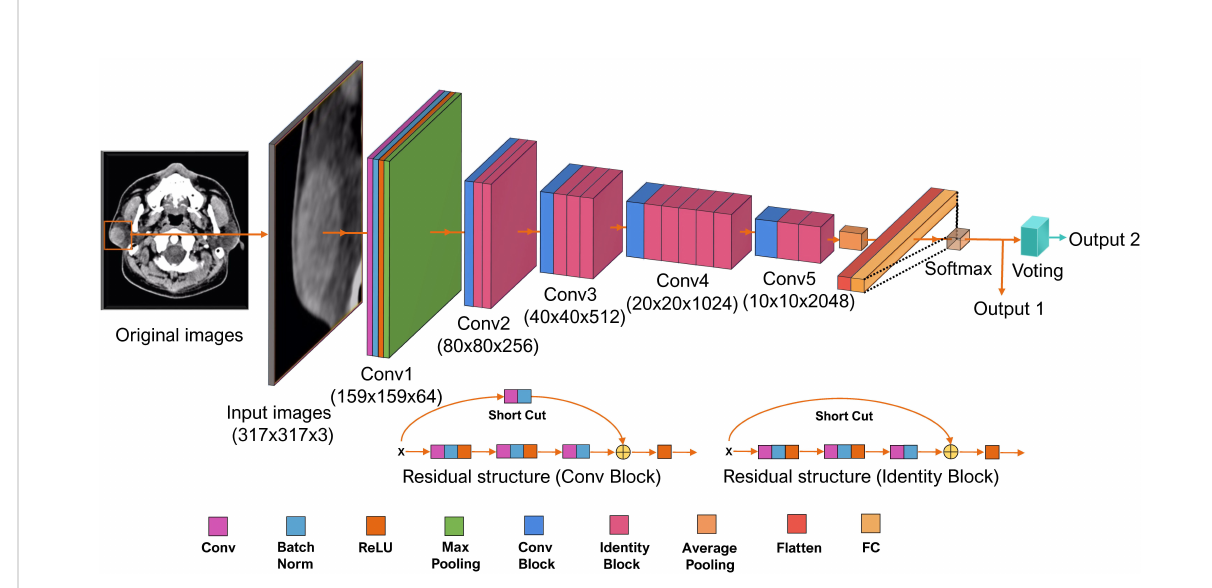
FIGURE 3 The structure of Residual neural network (ResNet) 50-layer model. The input data are the cropped plain computed tomography (CT) images with a resolution of 317 × 317. It propagated by ResNet through fi ve convolutional phases. Through the fi ve convolutional phases, the data were then processed with three fully connected layers. This ResNet model was structured to output two values; the bigger one indicating the classi fi cation of label 0 or label 1 for each CT images is output1. The results of output1 of each CT images are used to perform the fi nal voting. The most labels of output1 for a parotid lesion are output2. Batch Norm is the batch normalization; Conv is the Convolutional layer; FC is the fully connected layer; ReLU is the recti fi ed linear unit